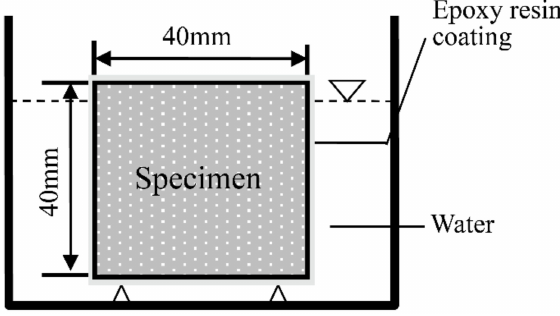
Figure 1. Schematic diagram of water absorption